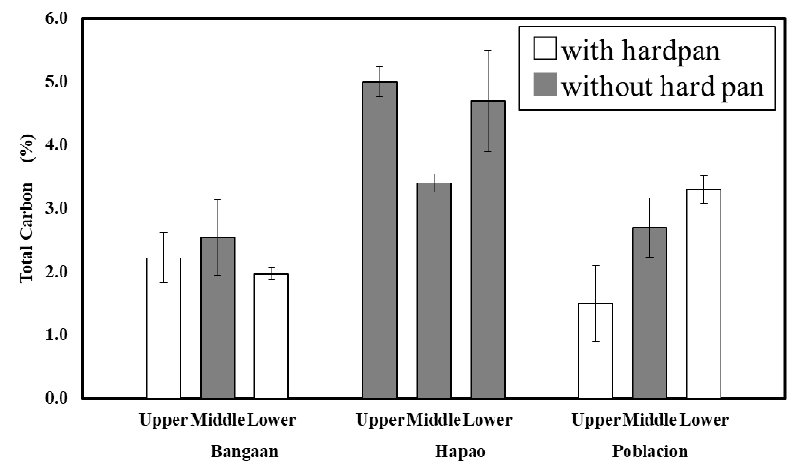
Figure 5. Total carbon content (%) for Bangaan, Hapao, and Poblacion.